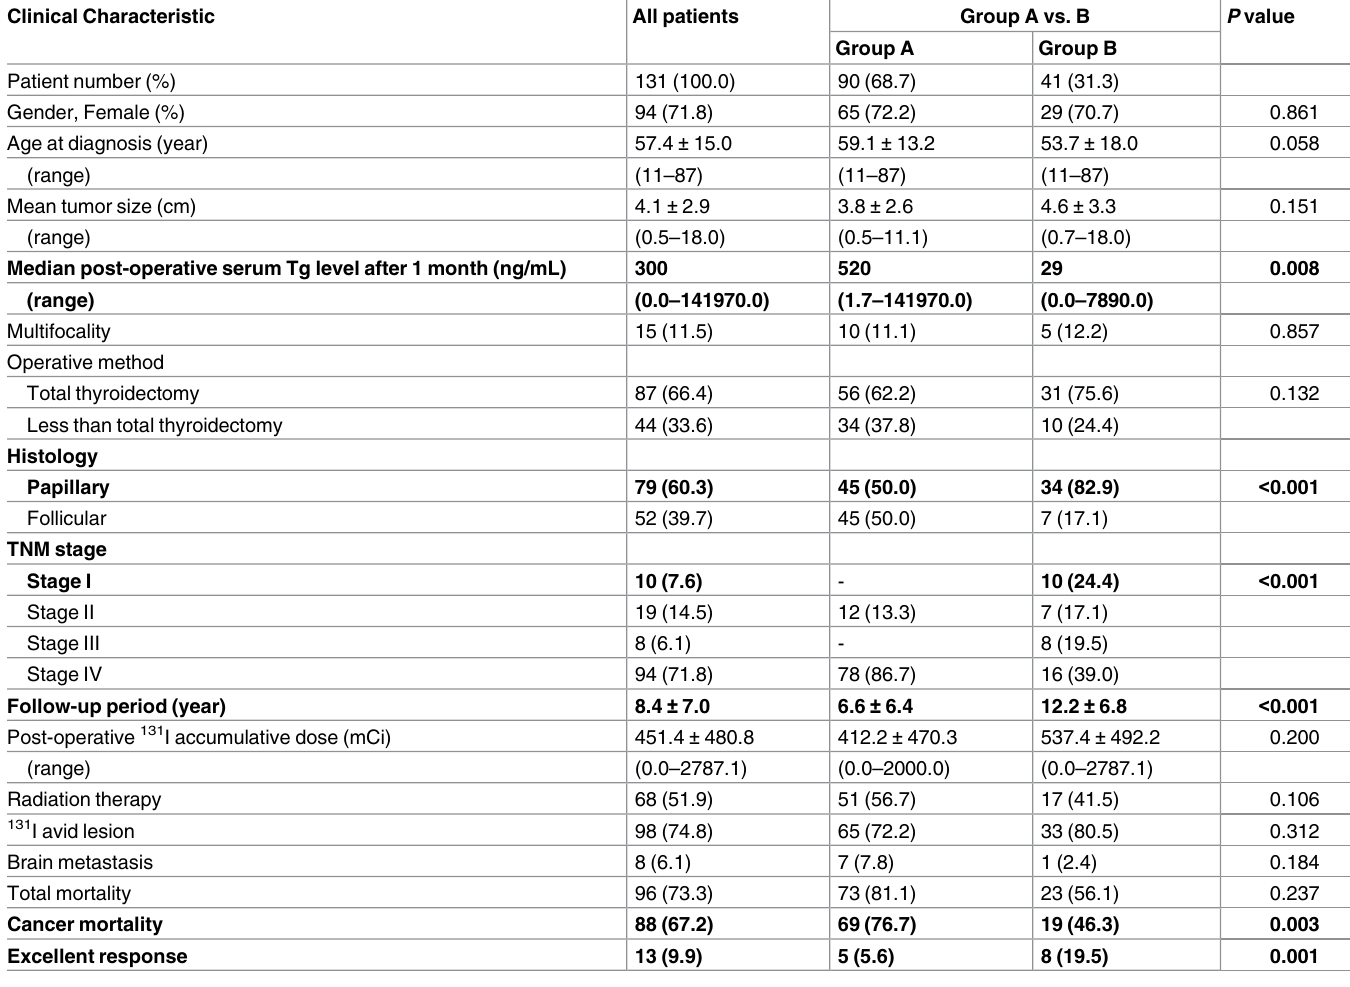
Table 1. Clinical featuresof papillary or follicular thyroid cancer with bone metastasis in different